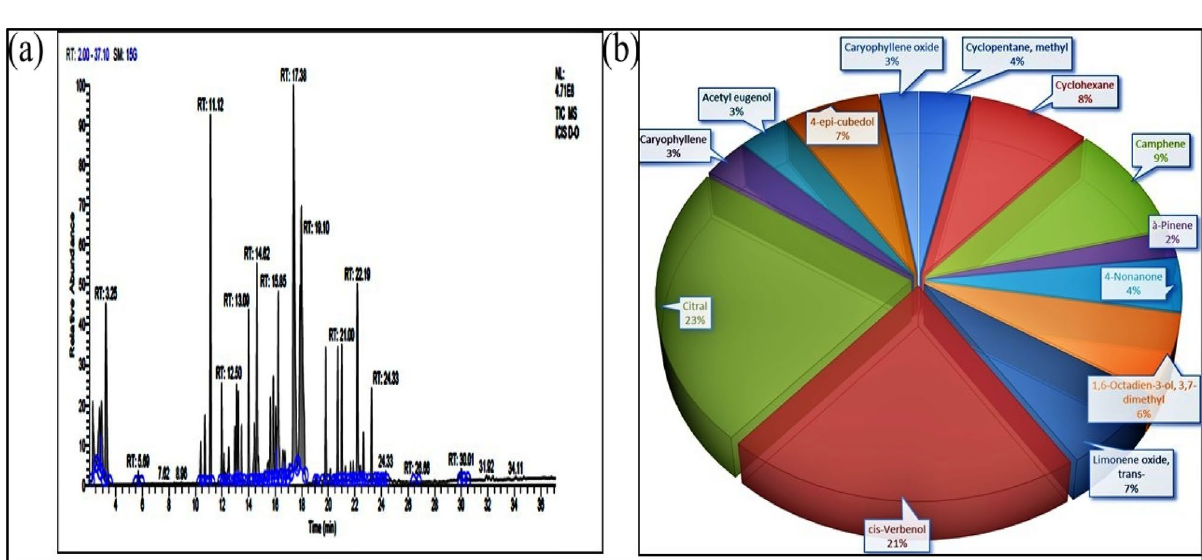
Figure 3. ( a ) Total ion chromatograms of GC–MS, ( b ) Percentage chemical composition of essential oil of C. flexuosus from site III—Dehradun